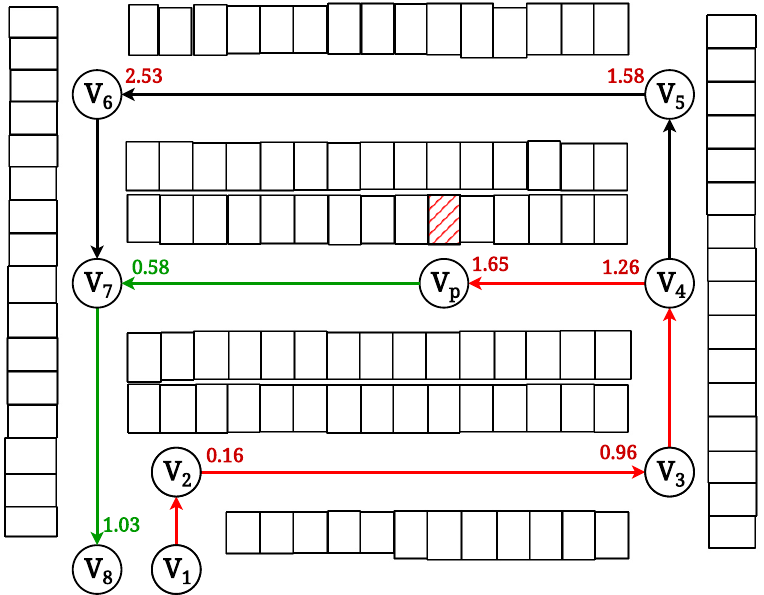
Figure 13. The process of route planning. The bounding box with red hatching is the target parking space. The calculated distance is next to the reached node. The right edge is the path guiding the vehicle to the parking space. The green edge is the path guiding the vehicle to the